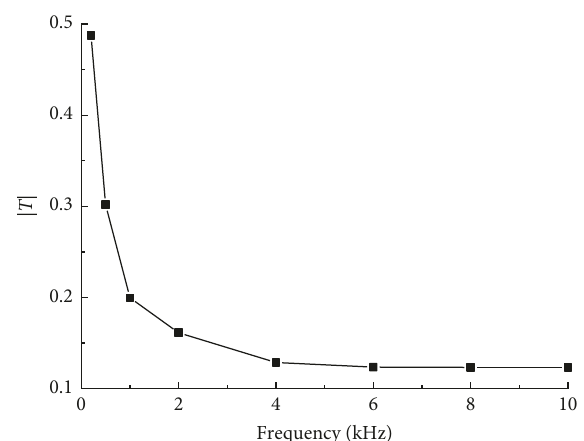
Figure 7: Magnitude of the transmission coefficient as a function of the incident wave